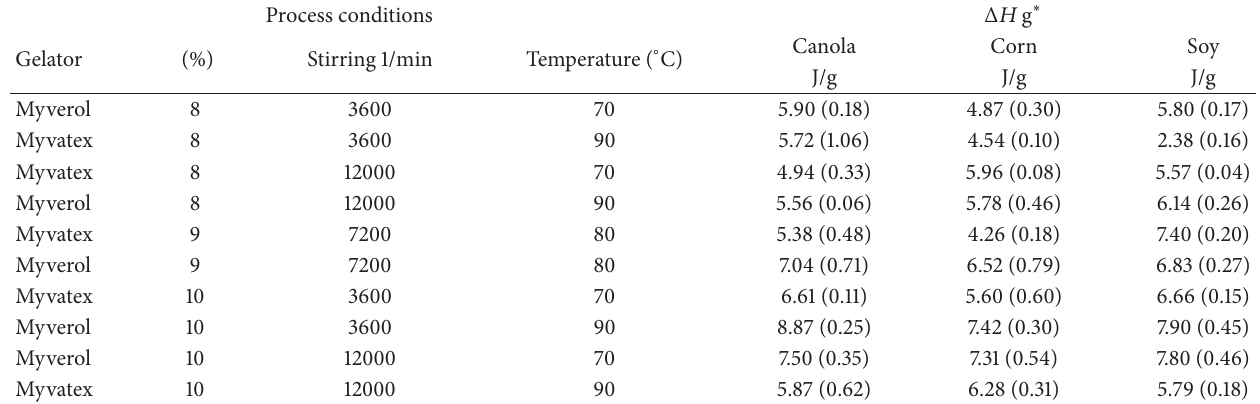
Table 1: Gelation enthalpy comparison for organogel samples.